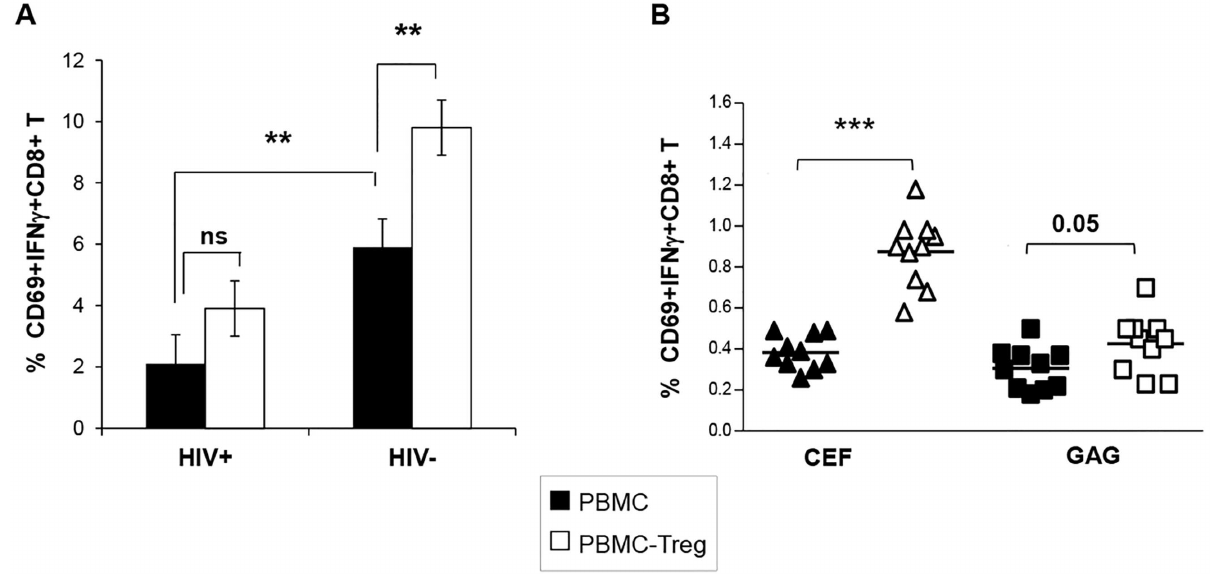
Fig 2. CD8 T cell sensitivity to Treg-mediated inhibition differs at the clonal level. A. Pooled data showingthe effect of Treg on the IFN- γ secretion of polyclonallystimulated CD8 T cells in 10HIV-1+ and in 10HIV- subjects. Bars represent mean ± SD. B. Individualdata showingthe percentageof IFN- γ secreting CD8 T cells after peptide-specific (CEF or Gag) stimulation of total and Treg-depleted PBMC from HIV+ ART- patients. ( * P < 0.05, ** P < 0.01, *** P < 0.001, n = 10, paired Student’s T-test).